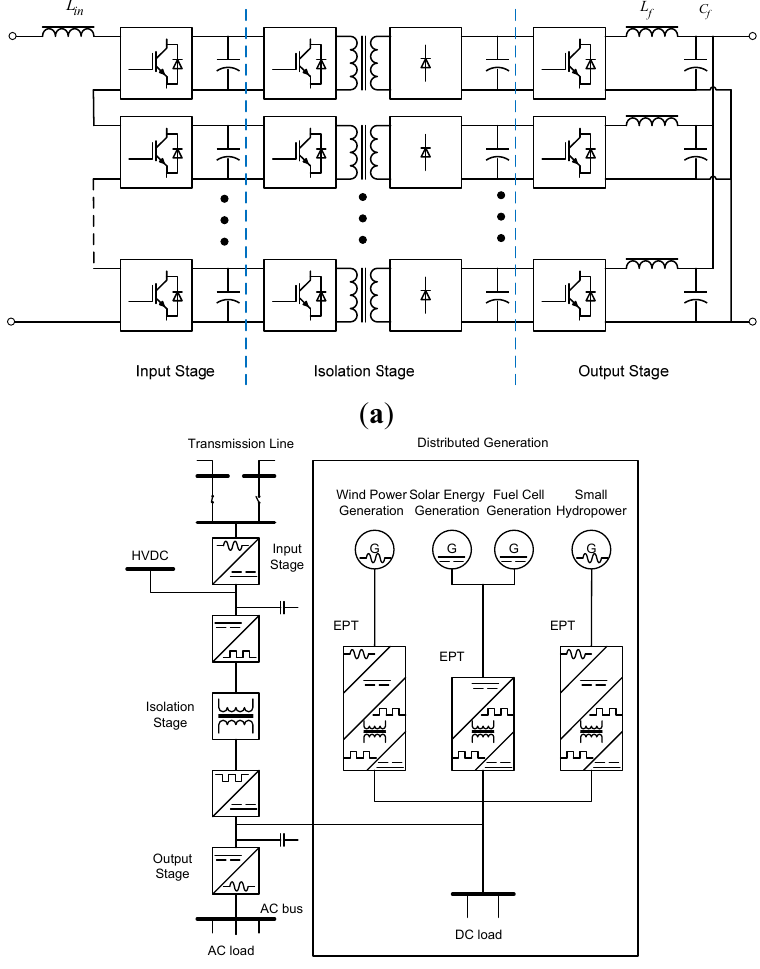
Figure 1. ( a ) Basic schematic of proposed D-EPT and ( b ) substation based on